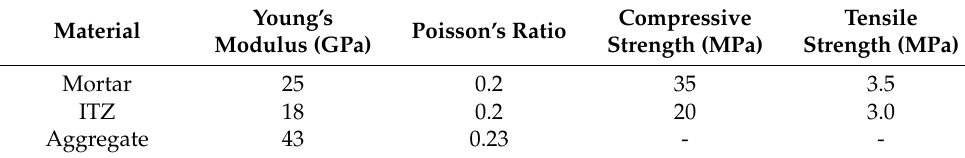
Table 2. Material parameters of the three-phase